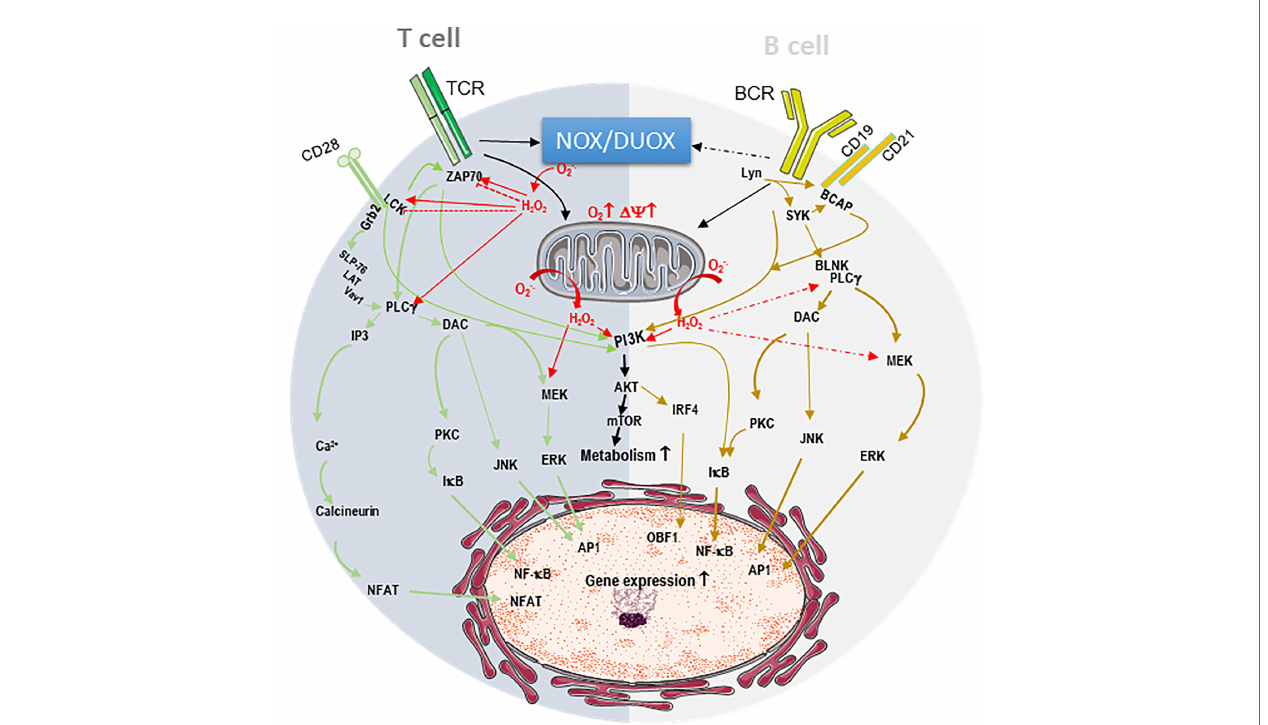
FIGURE 1 | Endogenous ROS contribute to T and B cell receptor signaling. The engagement of the B-cell receptor (BCR) or T-cell receptor (TCR) and their respective co-receptors CD28 and CD19/CD21 triggers intracellular phosphorylation signaling cascades resulting in the activation of transcription factors AP1, NF- k B, NFAT, OCA-B/OBF-1 IRF-4, which are critical for T and B lymphocyte activation. In T cell, dark grey, TCR/CD28 stimulation induces the phosphorylation and activation of the kinases p56lck (LCK) and ZAP-70, the phospholipase Cg (PLCg). CD28 recruits growth factor receptor bound protein 2 (Grb2), which docks the complex formed by SH2 domain containing leukocyte protein of 76kDa (SLP-76)/Linker for activation of T-cells (LAT)/signal transducer protein Vav1. The latter complex recruitment closer to the membrane facilitating its activation by ZAP70. PLCg generates inositol 3 phosphate (IP3) to mobilize intracellular Ca2 + stores resultingin the activation of the phosphatase calcineurin. PLCg also generates diacylglycerol (DAC) to activate protein kinase C (PKC), c-Jun N-terminal Kinase (JNK) and mitogen-activated protein kinase/extracellular signal-regulated kinases (MEK/ERK) cascade. Calcineurin dephosphorylates nuclear factor of activated T cells (NFAT), allowing its nuclear translocation. PKC allows NF- k B nuclear translocation by removing of the inhibitor (IkB), while JNK and ERK activate AP1. In B cells, light grey, BCR/CD19/CD21 stimulation initiates a phosphorylation cascade starting with the activation of the kinases Lyn and SYK, leading to the activation of B cell linker protein (BLNK), B Cell adaptor molecule for phosphoinositide 3-Kinase (PI3K) (BCAP) and PLCg, ultimately resulting in PKC, JNK and ERK activation. Both TCR and BCR signaling potentiate mitochondrial respiration and activate metabolic pathways through their action on the complex formed by PI3K, protein kinase B (PKB/AKT) and mammalian target of rapamycin (mTOR). These signaling cascades are potentiated by ROS (H2O2 and O2-.) from NADPH oxidases (NOX/DUAOX) and from the mitochondria (red arrows). In some instances, NOX triggers the oxidative modi fi cation of ZAP70 and LCK to precipitate their degradation and blunt activation (dashed bloc red